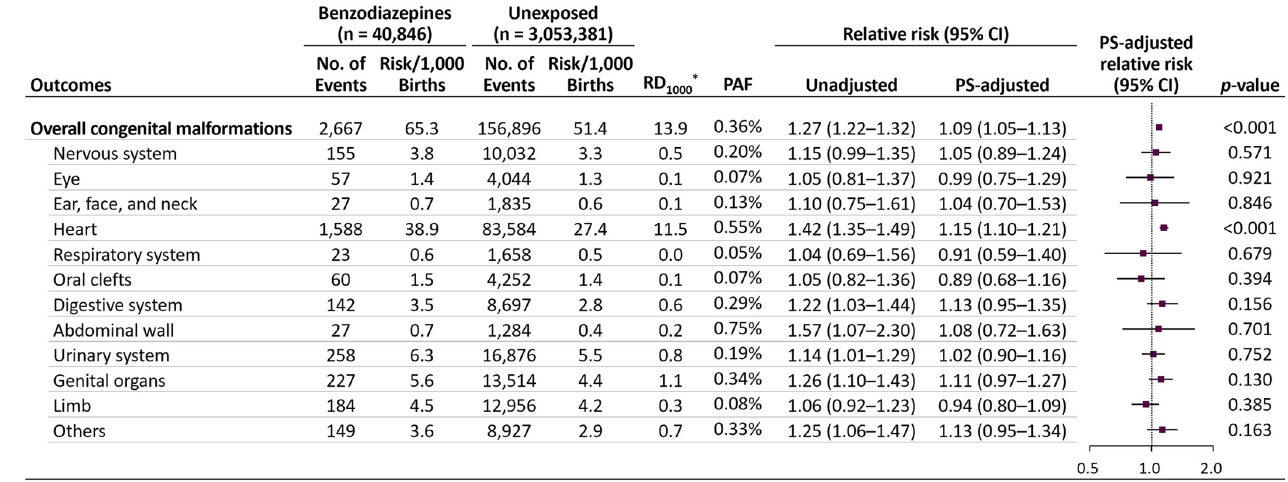
Fig 1. Absolute and relative risks of congenital malformations in infants following maternal exposure to benzodiazepines during the first trimester. CI, confidence interval; PAF, population attributable fraction; PS, propensity score; � RD 1000 , risk difference per 1,000 births.